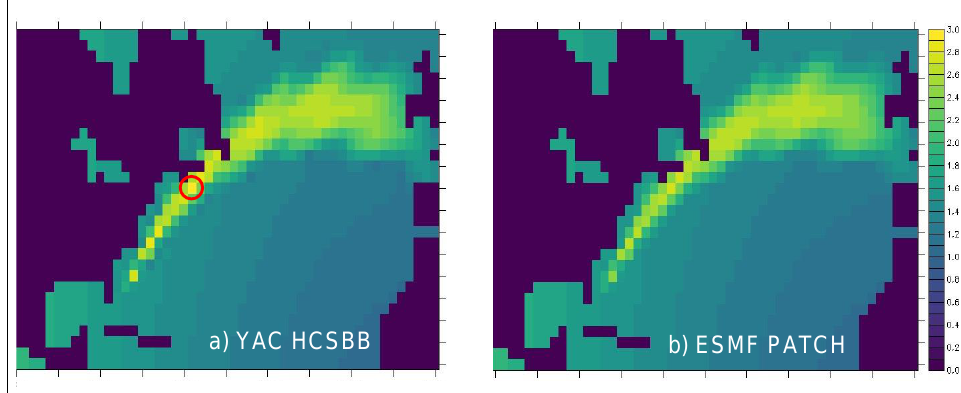
Figure 8. Misfit (%) for the gulfstream function in the gulf stream region for icos - torc regridded with the second-order non-conservative algorithm for ( a ) YAC HCSBB and ( b ) ESMF PATCH. The red circle identifies the highest, but a priori non-anomalous, value in the centre of the gulf stream for YAC discussed in the